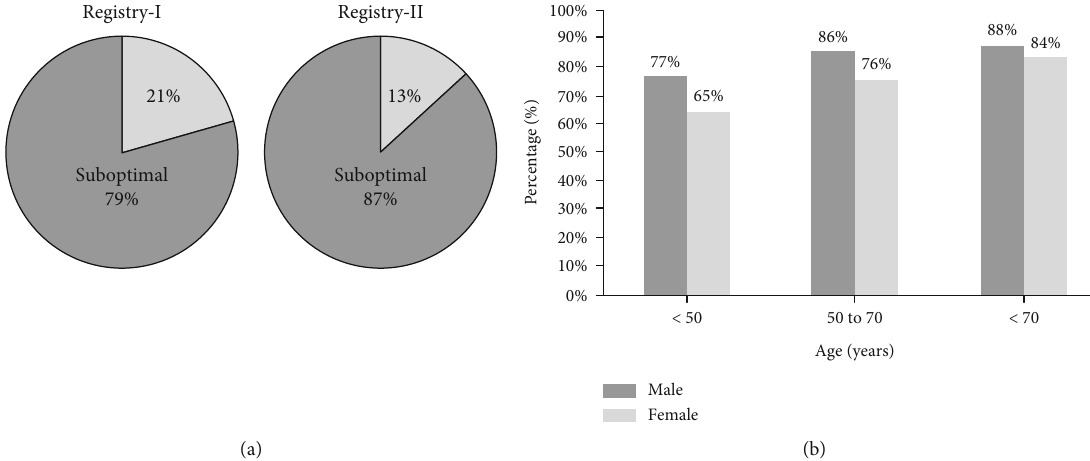
Figure 4: Prevalence of optimal and suboptimal vascular reactivity index (VRI) in Registry-I and Registry-II (a) and by gender and age group